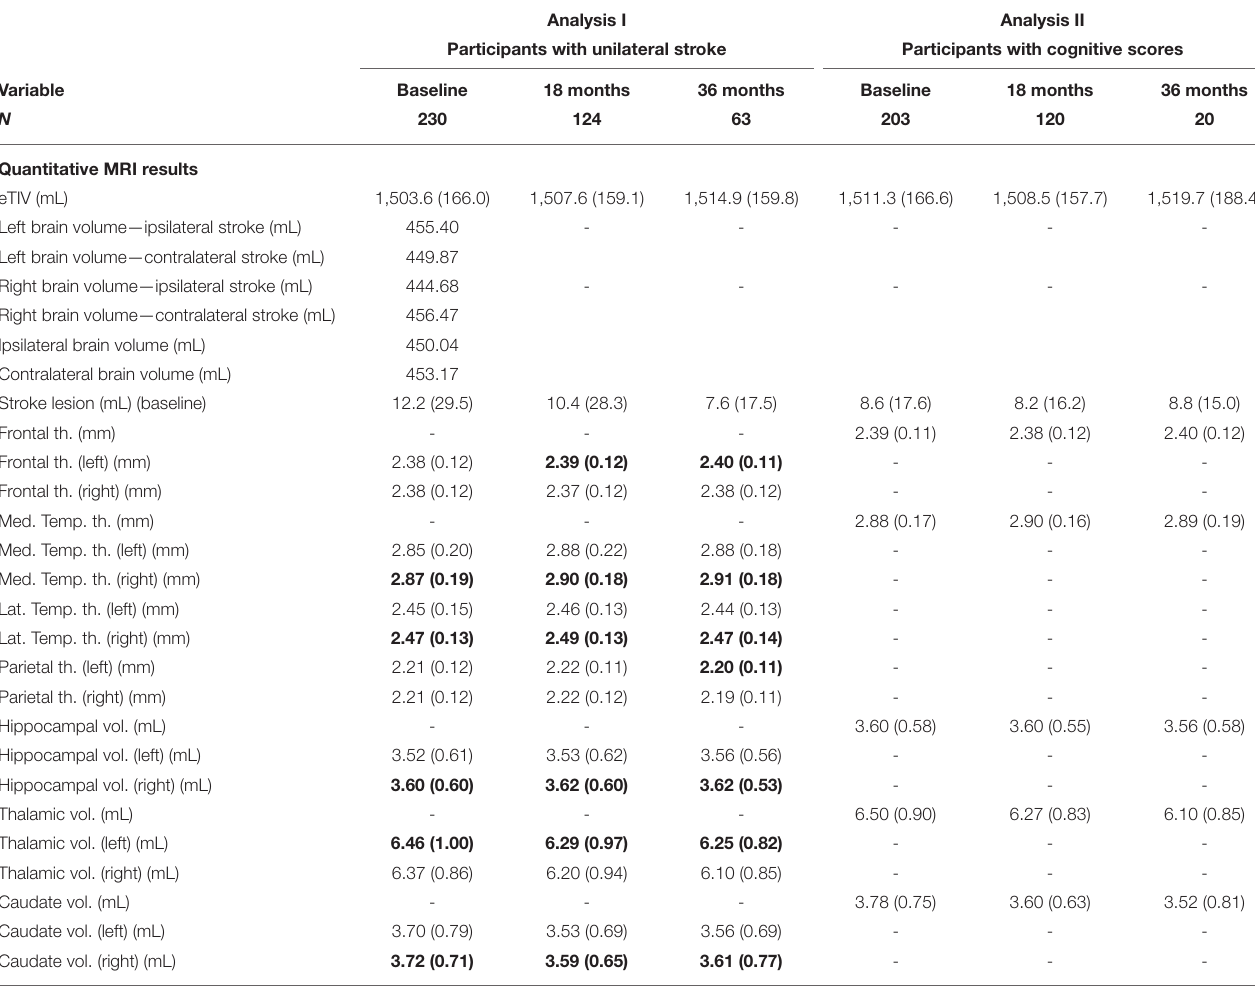
TABLE 2 | Participant’s structural MRI measurements, mean